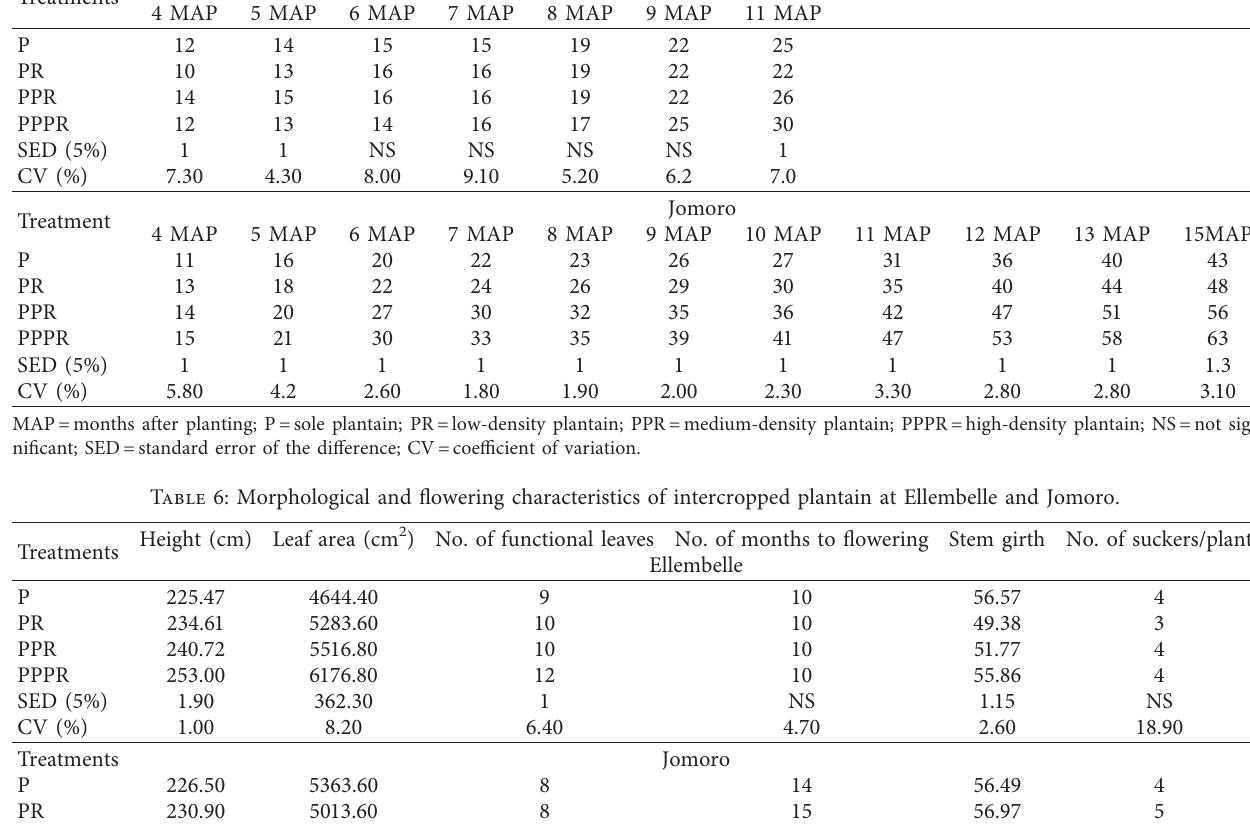
Table 5: Number of leaves of intercropped plantain at Ellembelle and Jomoro. Treatments